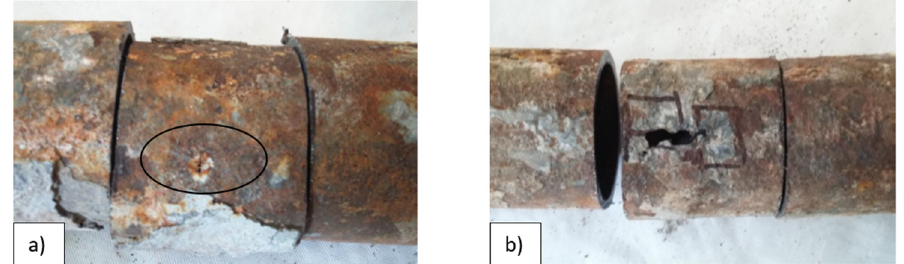
Figure 6. ( a ) Cutout 3 with a place of perforation of a small extent; ( b ) cutout 4 place of perforation of a large extent.